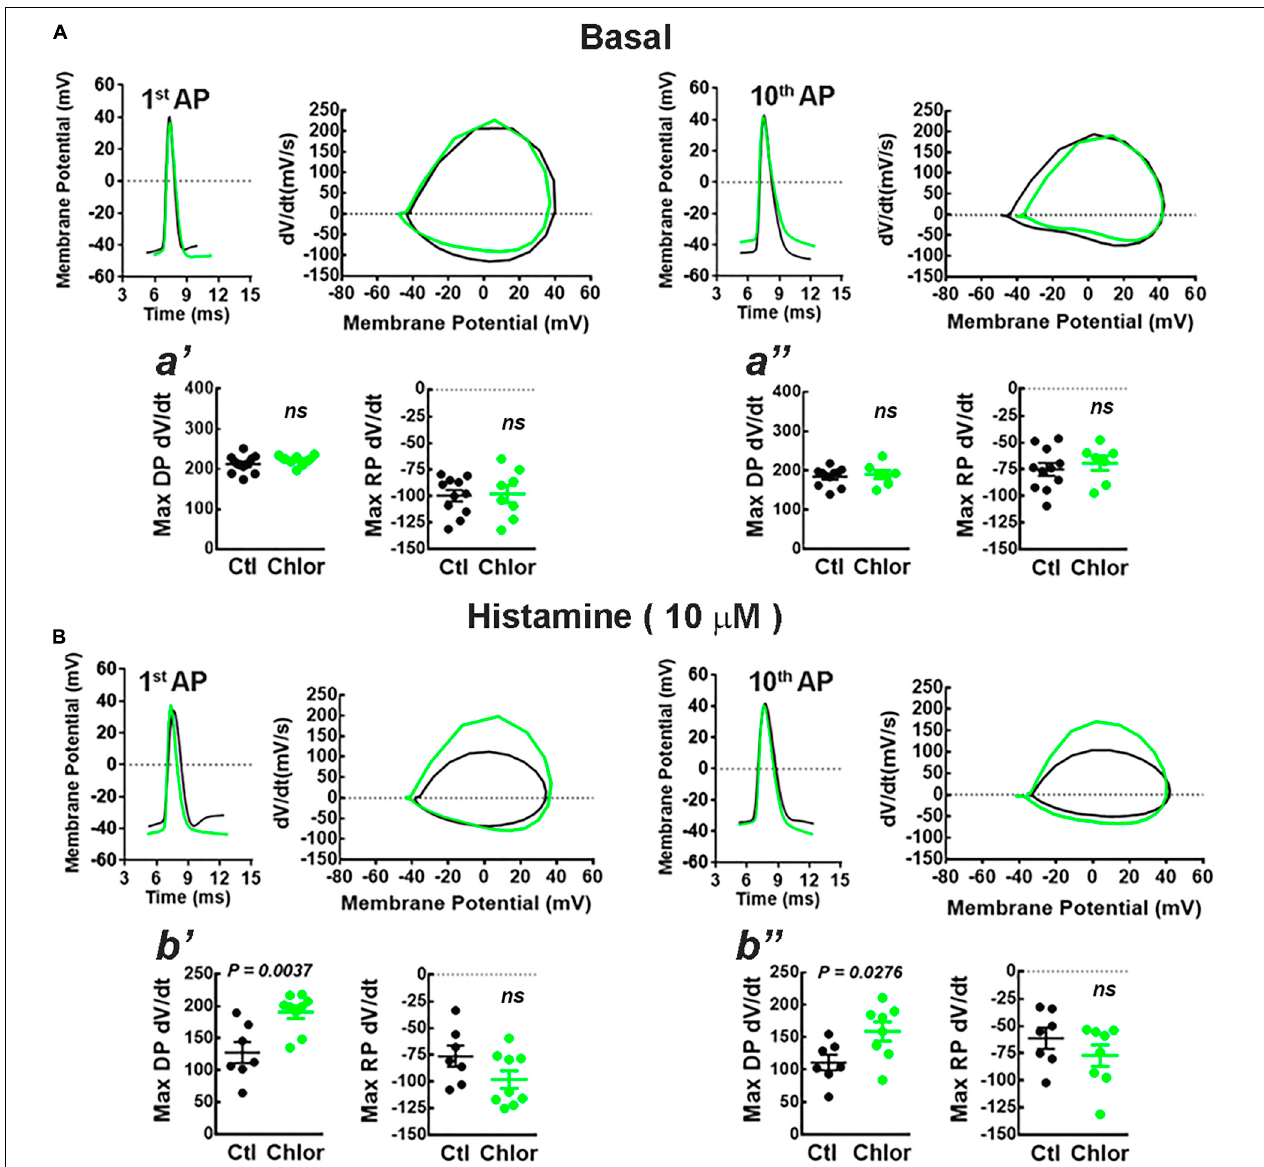
FIGURE 6 | Phase plot analysis of the action potentials. (A,B) Representative action potentials induced by the injection of depolarizing current (300 pA for 1 s) (left) and the corresponding phase plots (right) for the first (1st AP) and 10th (10th AP) action potentials from deep layers cortical neurons of the offspring of control (Ctl; black) and chlorpheniramine-treated (Chlor; green) dams in the absence (A) , (basal) or presence of 10 µ M histamine (B) . The graphs below (a (cid:48) , a (cid:48)(cid:48) , b (cid:48) , and b (cid:48)(cid:48) ) show the analyses of the maximum rate of the depolarization (Max DP dV/dt) and repolarization (Max RP dV/dt) phases of the 1st AP (a (cid:48) and b (cid:48) ) and 10 th AP (a (cid:48)(cid:48) and b (cid:48)(cid:48) ) under basal condition (a (cid:48) and a (cid:48)(cid:48) ) or histamine stimulation (b (cid:48) : Max DP dV/dt: t = 3.48, df = 11; b (cid:48)(cid:48) : Max DP dV/dt: t = 2.48, df = 13) for the Control (Ctl; black) and chlorpheniramine (Chlor; green) groups. Values are means ± SEM from 7 to 11 neurons for each condition of 6 P21 animals from three different litters per group. The statistical analysis was performed with unpaired Student’s t -test. ns, non-significant